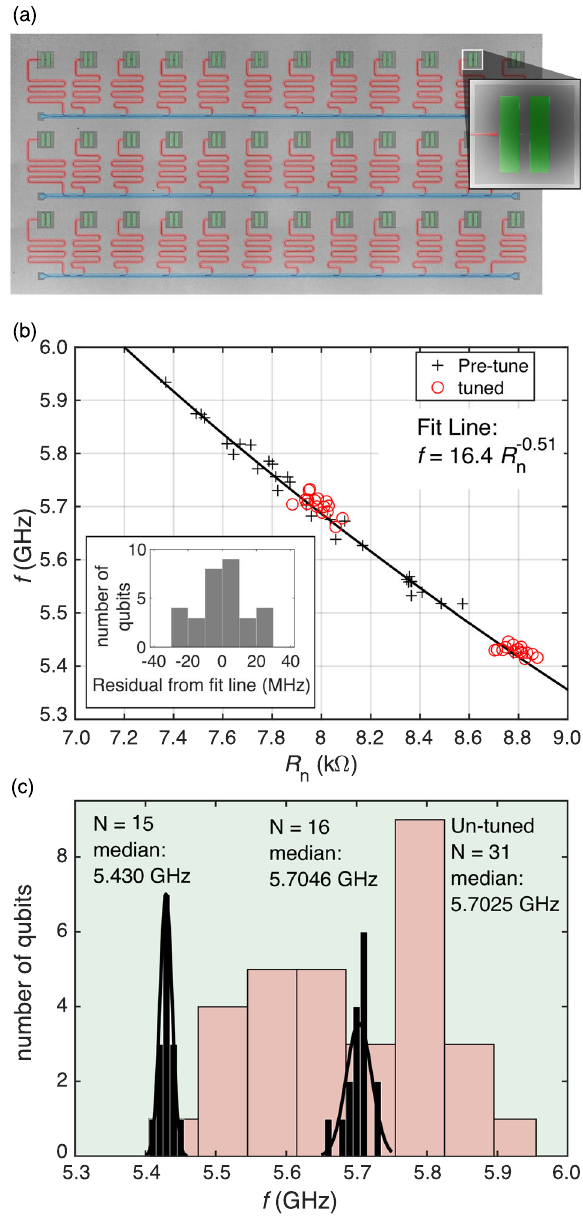
Fig. 1 Frequency precision σ f . a False-colored image of test-vehicle chip. Thirty-six fi xed-frequency transmon qubits, each including a 500× 320 micron planar capacitor (green) and a ~0.1×0.1 micron Al/AlO x /Al tunnel junction, are prepared identically on a 20×10mm Si substrate. A half-wavelength coplanar waveguide resonator at each qubit (red) enables dispersive readout. Resonators are frequency-multiplexed in groups of 12 per feedline (blue). b Plot of transmon frequency vs R n , and power-law fi t of pre-tuned population. Inset histogram (10MHz bins) shows residual scatter in frequency relative to fi t line. c Distributions of qubit frequencies. Initial median was 5.7025GHz and initial spread was = 132.3MHz (red histogram, 70MHz bins). Using selective laser σ f anneal (Fig. 2), we prepared these qubits into two distinct frequency populations with medians 5.430 and 5.7046GHz (black histograms, 10MHz bins). Each population is outlined by a Gaussian curve centered at its local median frequency. Combined spread is σ f =